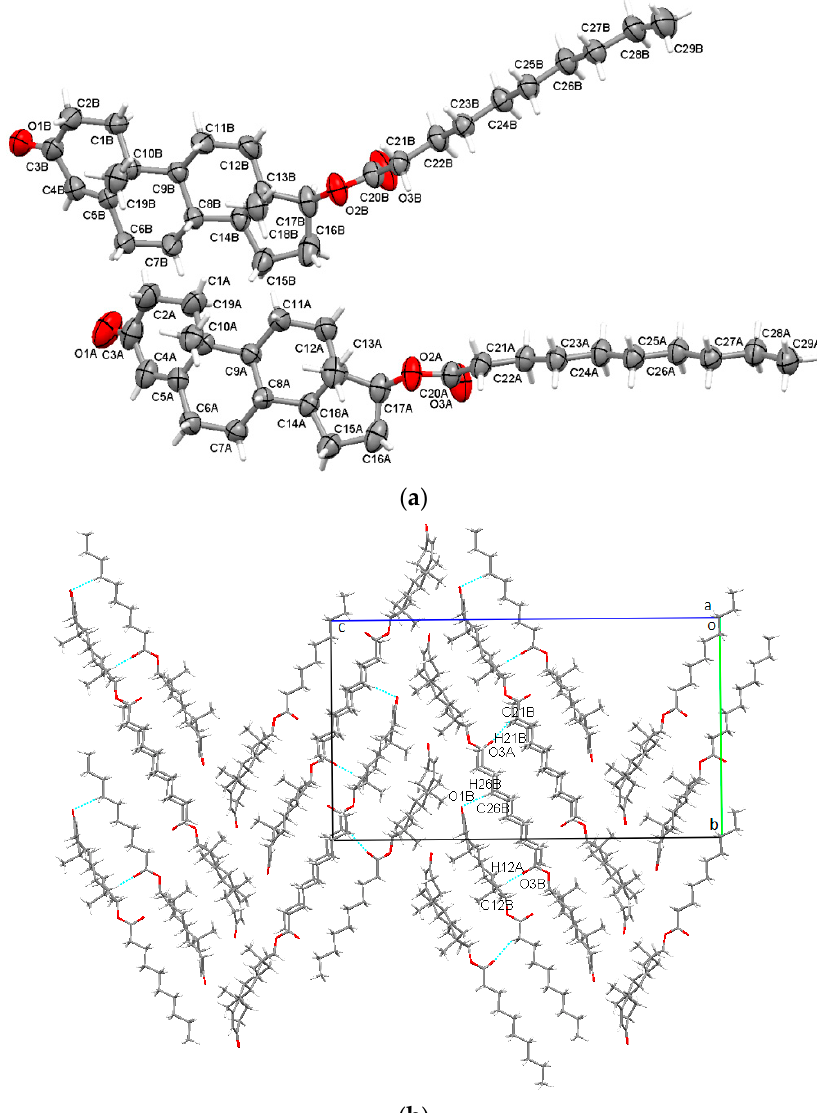
Figure 4. Asymmetric unit of TDec presenting non-hydrogen atoms at 50% probability level ( a ); overall packing viewed along a-axis ( b ) .